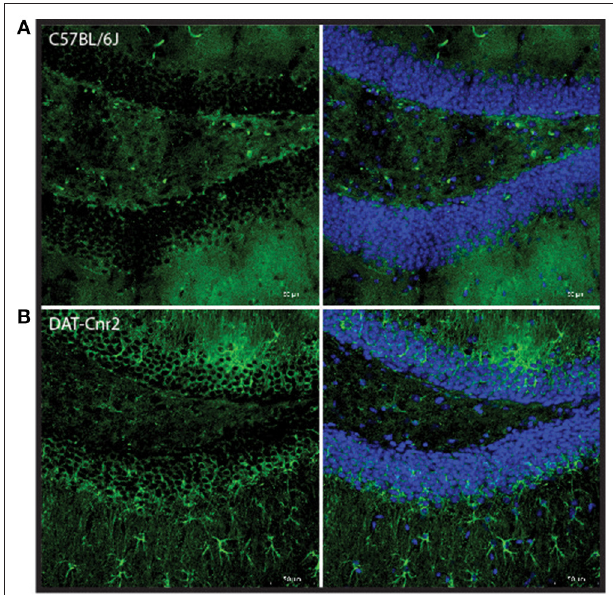
FIGURE 8 | Representative images of Cd11b staining in dentate gyrus region of the hippocampus in male C57BL/6J (A) and DAT- Cnr2 cKO (B) male mice. Cd11b immunofluorescence (green). Merged immunofluorescence of Cd11b and DAPI (blue).